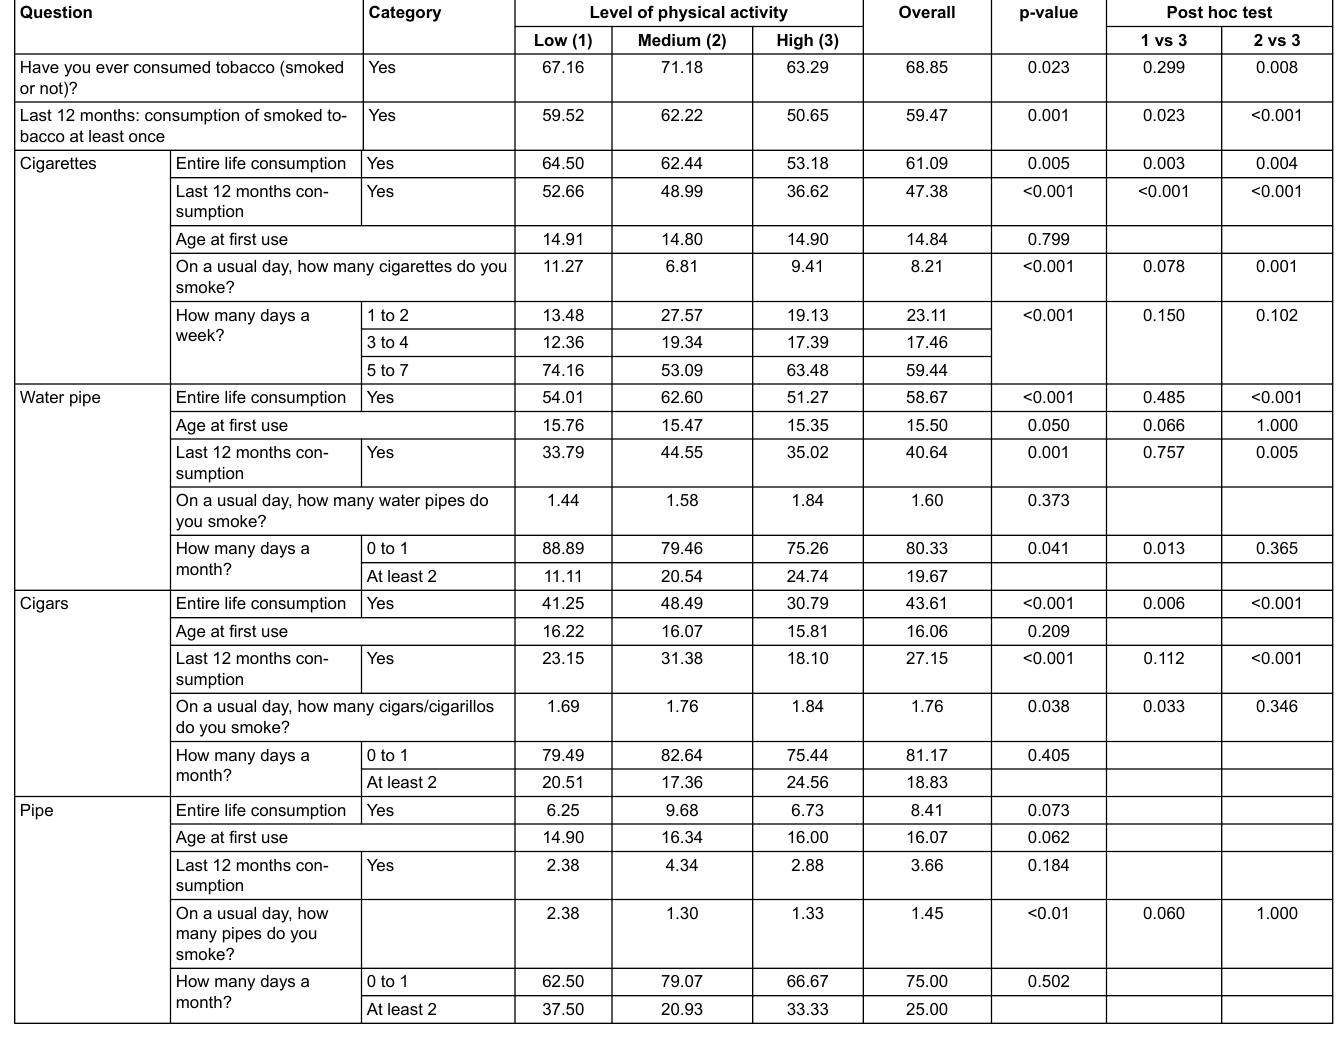
Table 3: Smoked tobacco consumption by level of physical